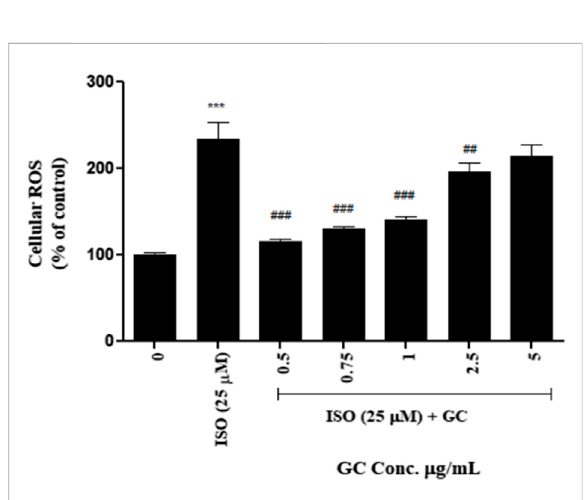
FIGURE 3 Intracellular ROS detection assay in ISO (25 µM) induced cardiotoxicity model in H9c2 cell line with GC pretreatment at differentconcentrations (µg/ml). Data expressed as mean ± SD for groups of three observations. Statistically signi fi cant *** p < 0.001comparedtocontrolgroupand### p < 0.001comparedto ISO group as calculated by one-way ANOVA followed by Dunnet ’ s multiple comparison